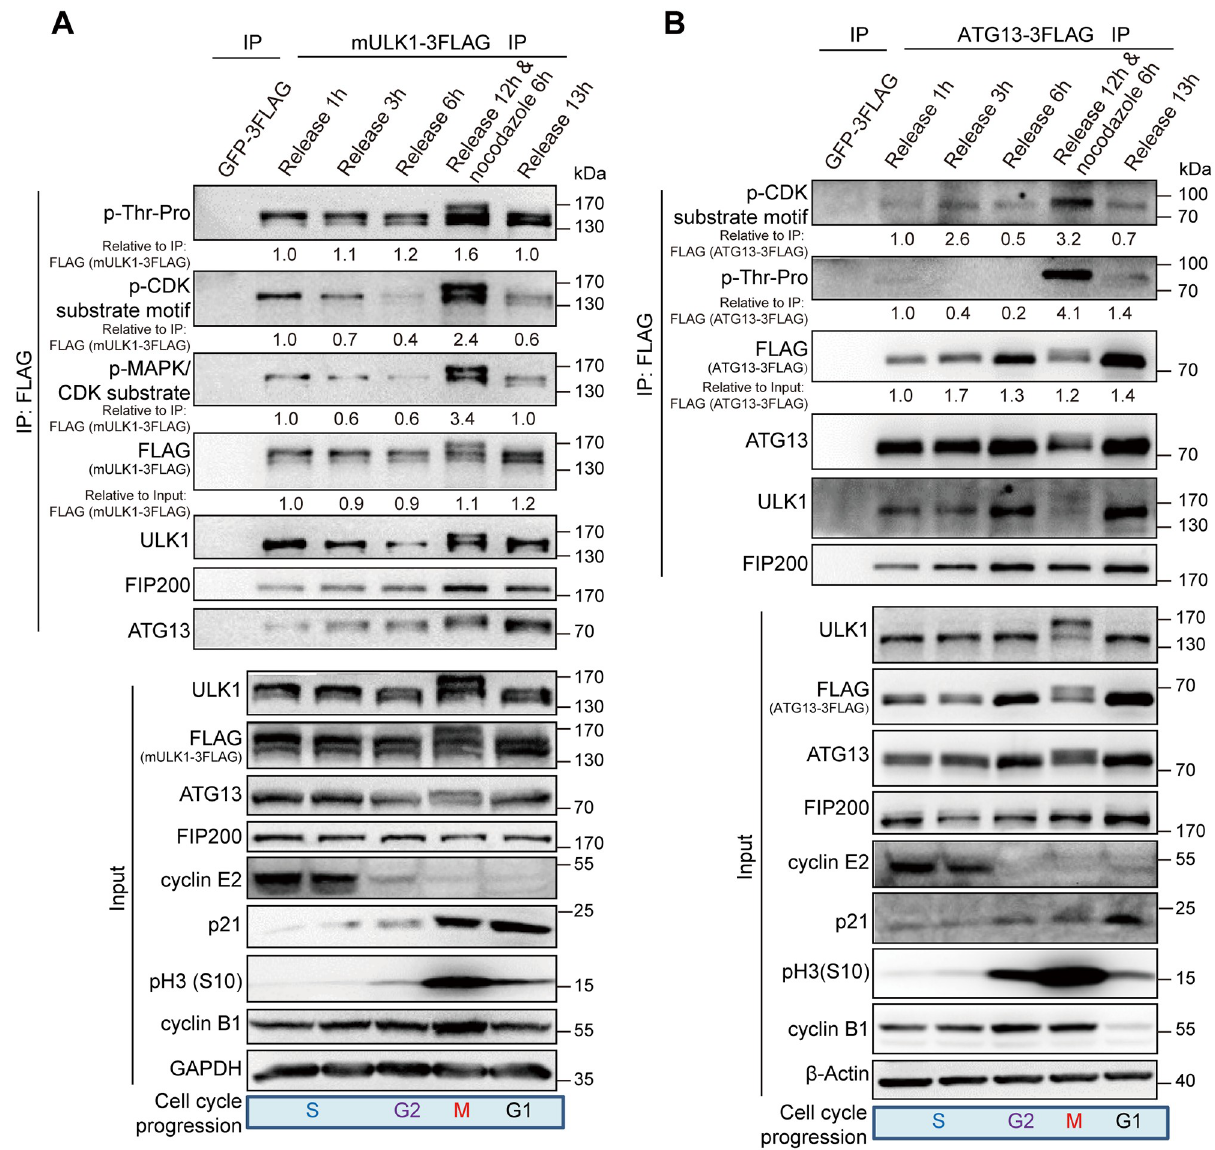
Fig 2. ULK1-ATG13 can be recognized by CDK substrate phosphorylation antibodies. (A-B) ULK1-ATG13 upshifted band in mitosis could be recognized by CDK substrate-specific antibodies. The 293T cells stably expressing FLAG-tagged mULK1 or ATG13 were synchronized by single- thymidine and released in the presence or absence of nocodazole. The coimmunoprecipitates and input were immunoblotted with specific antibodies. The phospho-signal was quantified relative to the FLAG antibody–detected bands (mULK1/ATG13-3FLAG) in IP; the IP signal of mULK1/ATG13- 3FLAG was quantified relative to its input. Various cell cycle markers were detected to show the respective phases of cell cycle. ATG, autophagy-related; CDK, cyclin-dependent kinase; FIP200, FAK family-interacting protein of 200 kDa; GAPDH, glyceraldehyde 3-phosphate dehydrogenase; GFP, green fluorescent protein; IP, immunoprecipitation; mULK1, mouse ULK1; p-MAPK, phospho mitogen-activated protein kinase; ULK1, unc-51-like autophagy activating kinase 1.